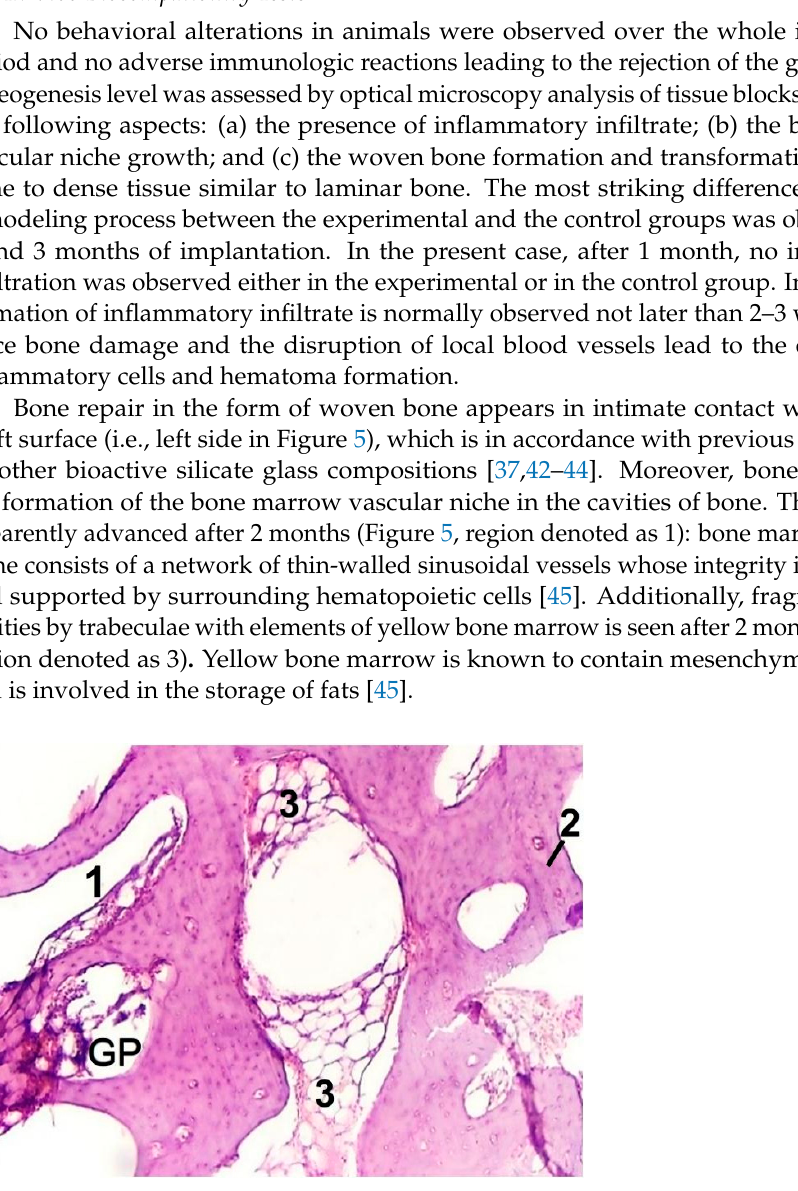
Figure 6. Histopathological sections in cortical area of femur treated with glass powder (experimental group after 3 months, original magnification 10.0×). Legend: 1—the bone marrow vascular niche; 2—old bone; 3—fat inclusions to yellow bone marrow; 4—new bone; 5—the boundaries of bone tissue and bone graft merge (signs of regeneration). The absence of the inflammatory infiltrate in the wound treated with the 47.5 B bioactive glass powder shows that this bone graft, although a foreign body, is biocompatible and does not induce an exacerbated inflammatory response. The boundaries of new and old bone tissue merge (Figure 6, region denoted as 5), signifying perfect osteogenesis. In the lower fragment of Figure 6 one can see the osteoid bony plates around the blood vessels. Blood vessel ingrowth is essential to the formation of a soft callus containing fibroblasts and chondroblasts. Furthermore, intramembranous ossification leads to the generation of a bone cuff while endochondral bone formation converts the callus into rigid calcified tissue. Both mineralization and vascular remodeling processes in the callus result in repair of the damaged bone [46–48].